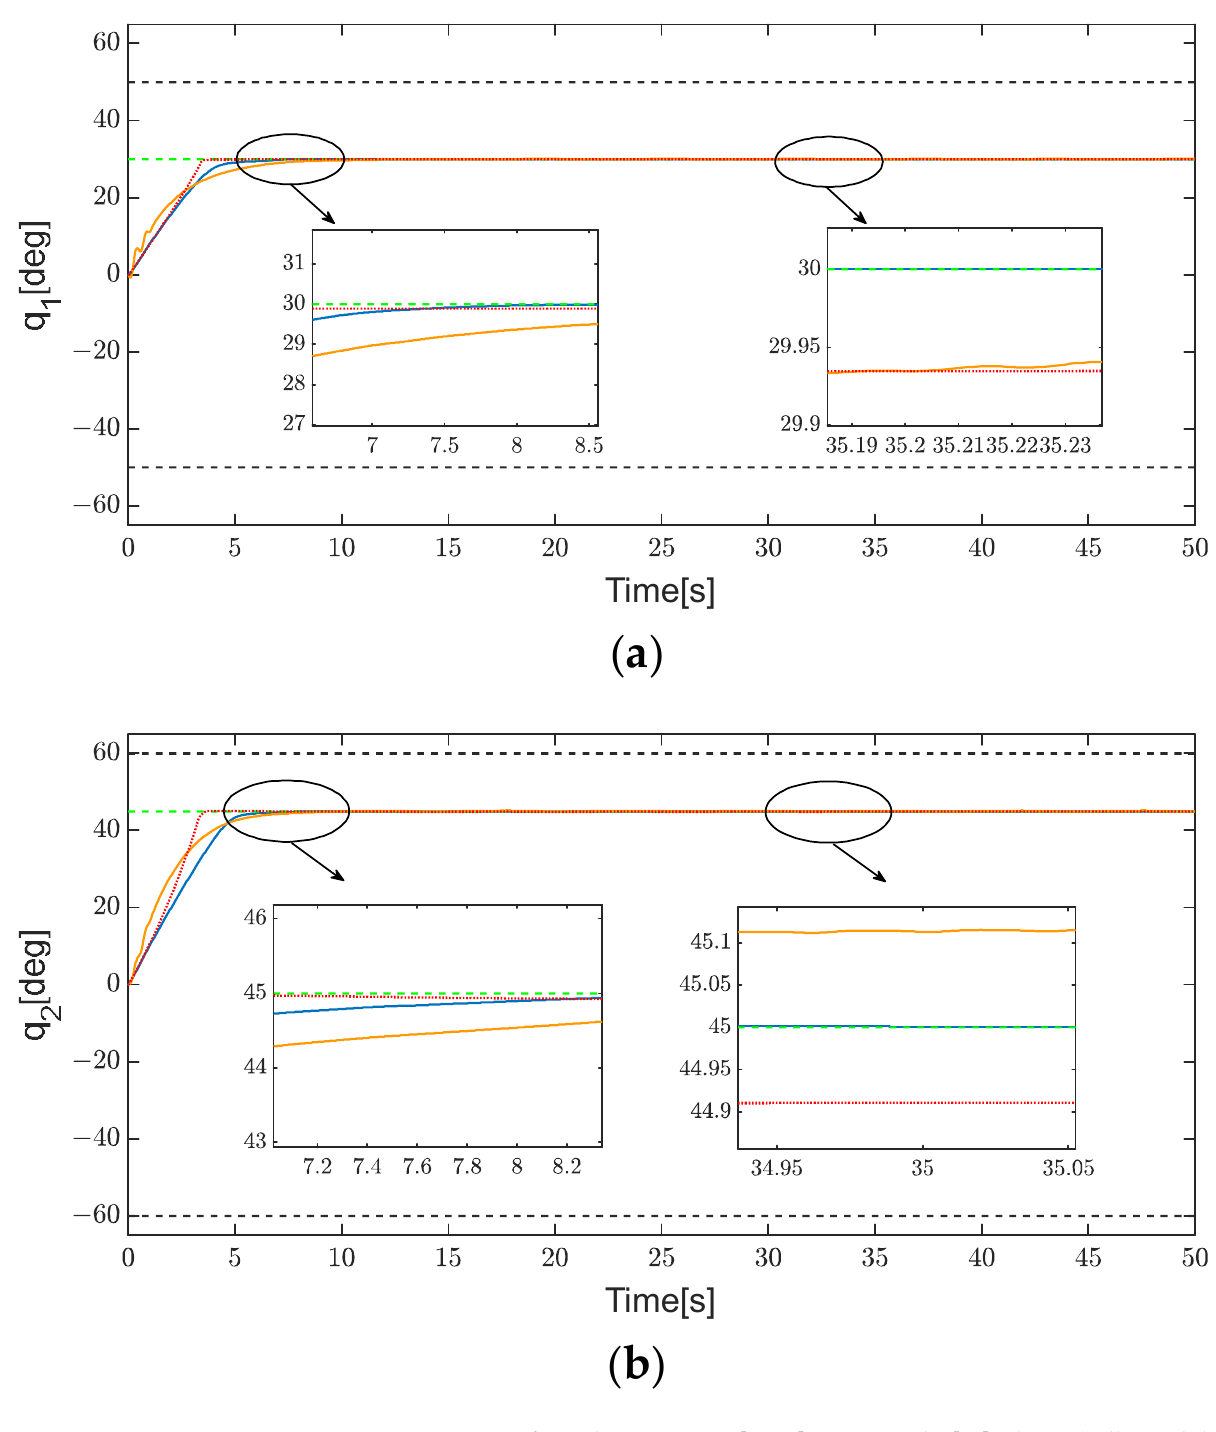
Figure 13. Comparison of angular position to [43,44] in case 2: The [43] scheme (yellow solid line), the [44] scheme (red dash line), the proposed scheme (blue solid line), the reference angular position (green dashed line), the angular position constrains (black dashed line); ( a ) Joint 1. ( b ) Joint